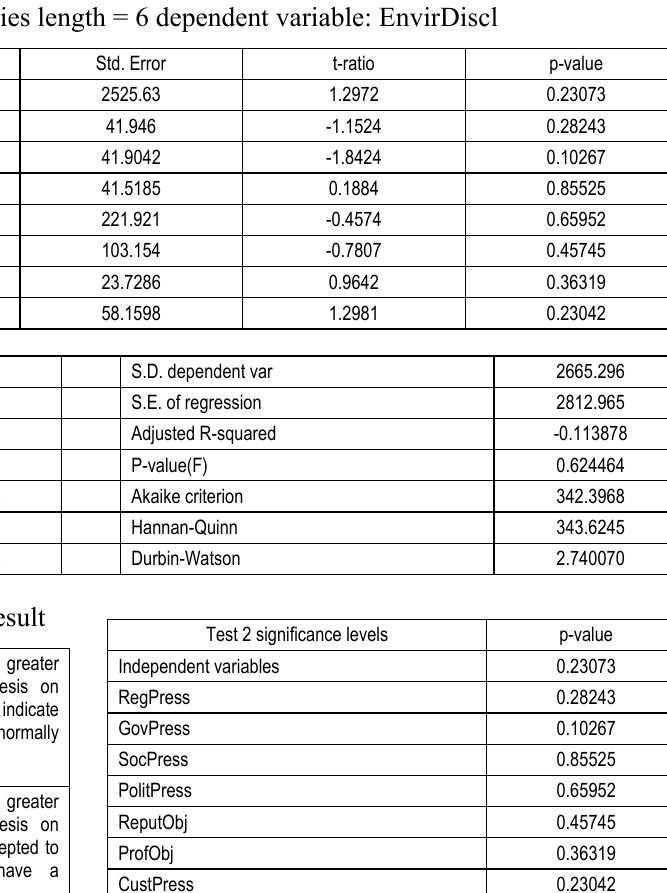
Table 1. Regression output on the test of hypothesis model 2: fixed-effects, using 18 observations included 3 cross-sectional units time-series length = 6 dependent variable: EnvirDiscl